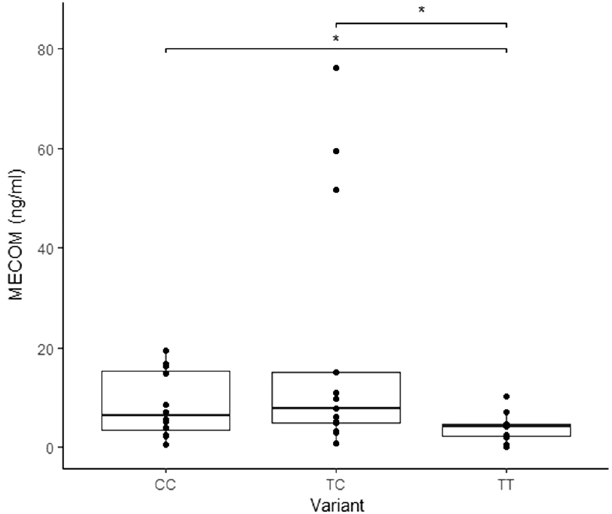
Figure 4. The MECOM expression is associated with the rs43744169. MECOM protein levels in plasmas from homozygous and heterozygous cows in the rs43744169 were measured with a bovine ELISA. Samples were selected from the case–control population and grouped according to the rs43744169 genotypes. Cows with the alleles T/C (N = 13) and C/C (N = 12) were associated with elevated MECOM protein levels when compared with the MECOM levels in the plasmas from cows with the two major alleles T/T (N = 11); P = 0.05 and P = 0.03, respectively. The median and the upper and lower quartiles of each group are represented by horizontal and vertical lines, respectively. The lowest point is the minimum of the data set and the highest point is the maximum of the data set. P-values were calculated using an unpaired t-test. *P-value ≤ 0.05. Each sample is represented by a circle on the dot plot.